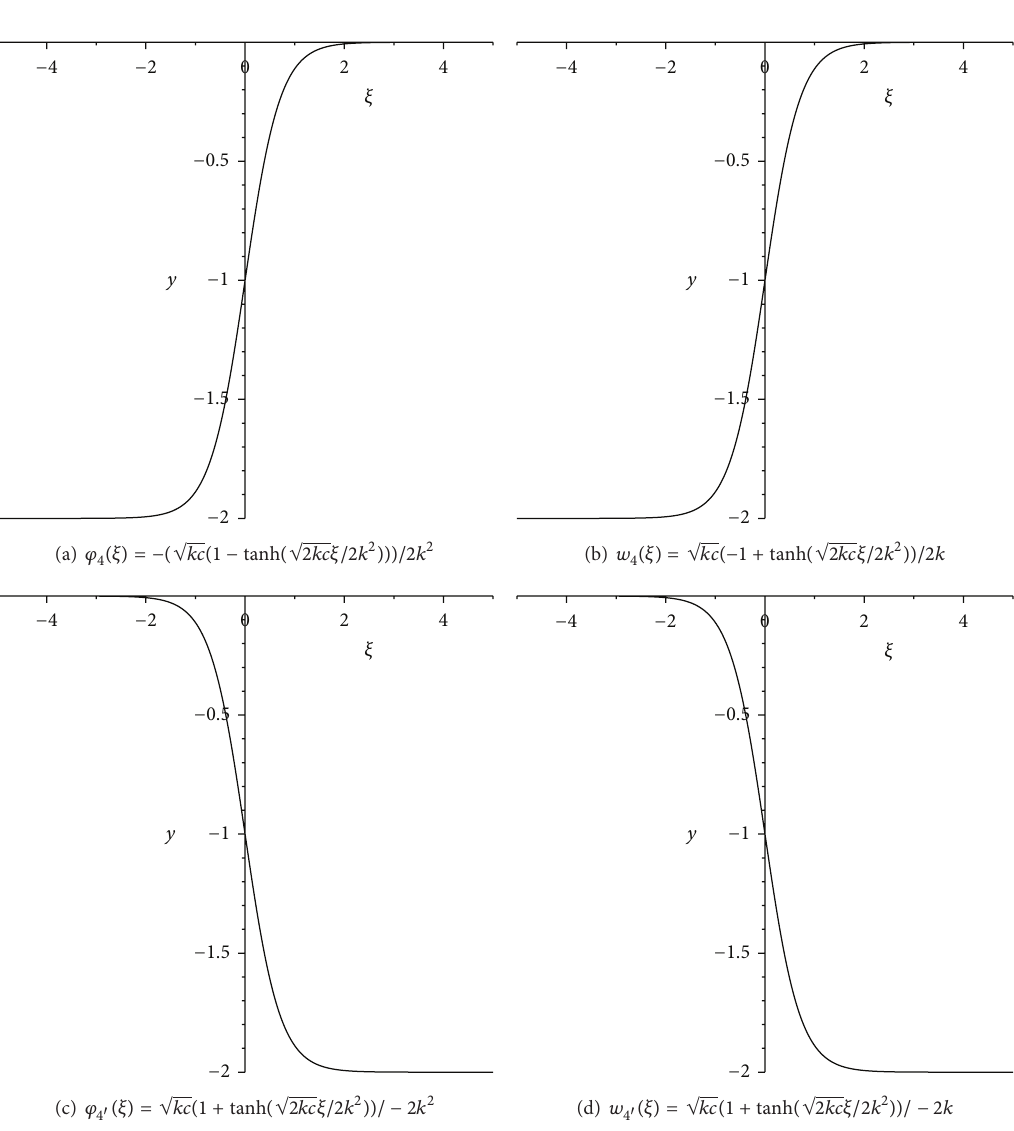
Using the potential (4), the kink wave solution for the system (3) are obtained as